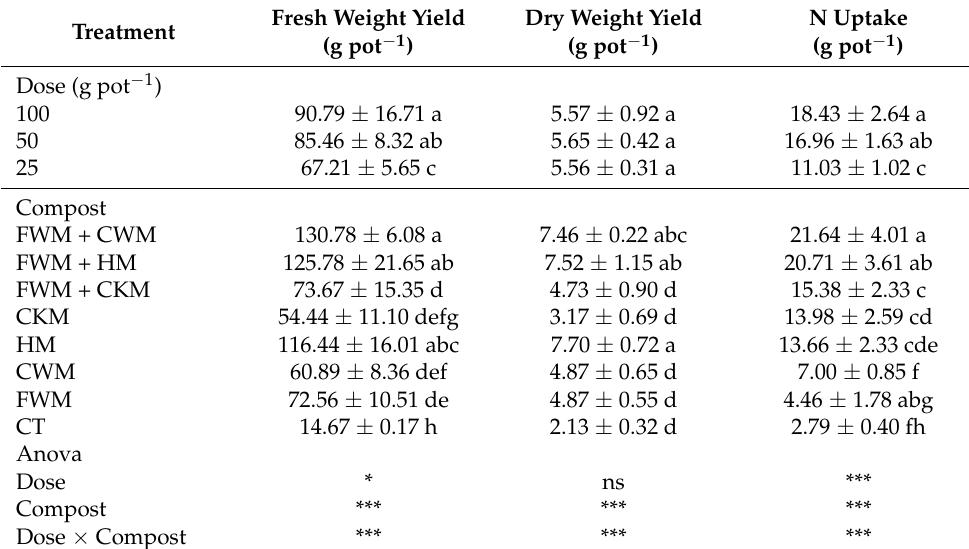
Table 3. Yield and nitrogen uptake of komatsuna under different doses and compost.